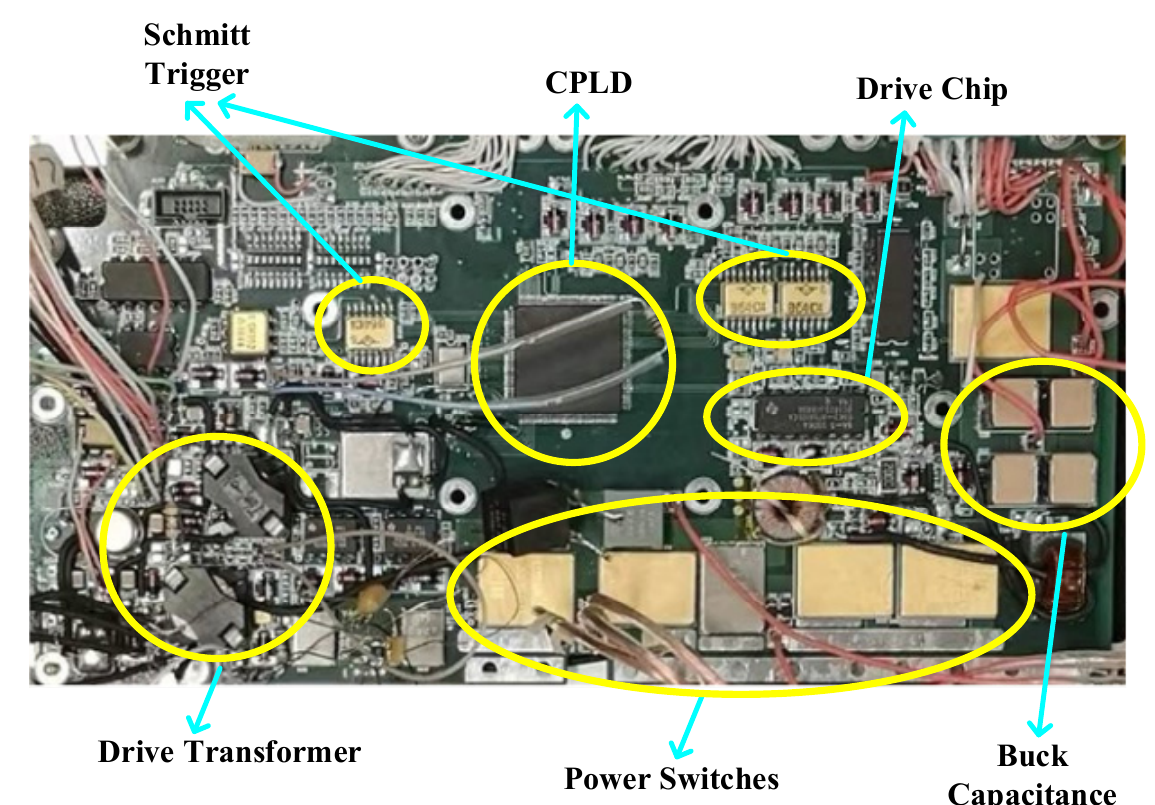
Figure 9. Experimental converter in the laboratory. The voltage and current waveforms of the second-stage push–pull switches of the prototype are presented in Figure 10.